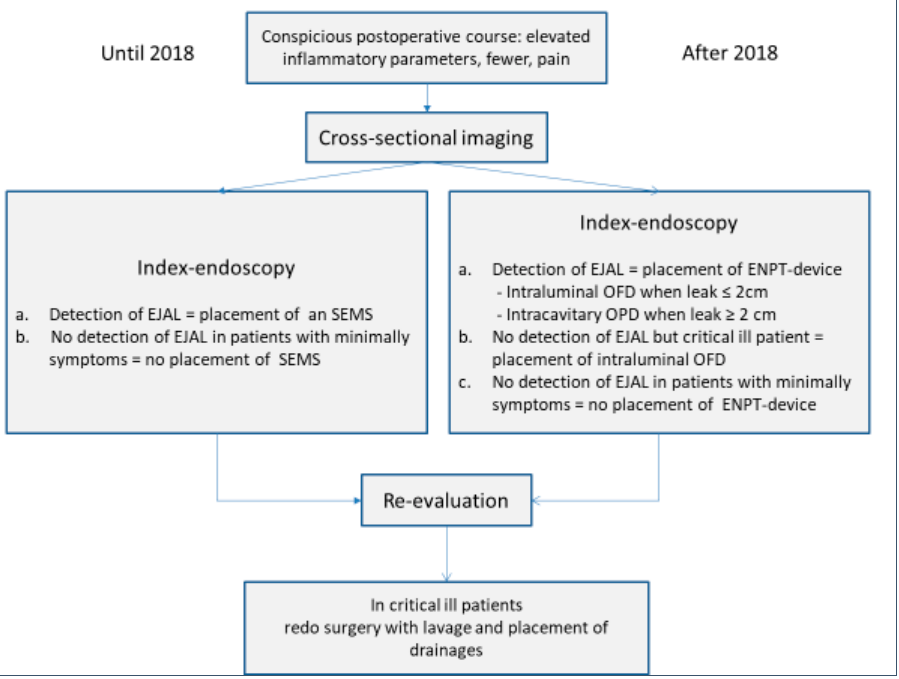
Figure 1. Flowchart of diagnosis and endoscopic treatment until and after 2018. EJAL = esophagojejunal anastomotic leak, SEMS = self-expandable metal stent, ENPT = endoscopic negative pressure therapy, OFD = open-pore film drainage, OPD = open-pore polyurethane sponge drainage.